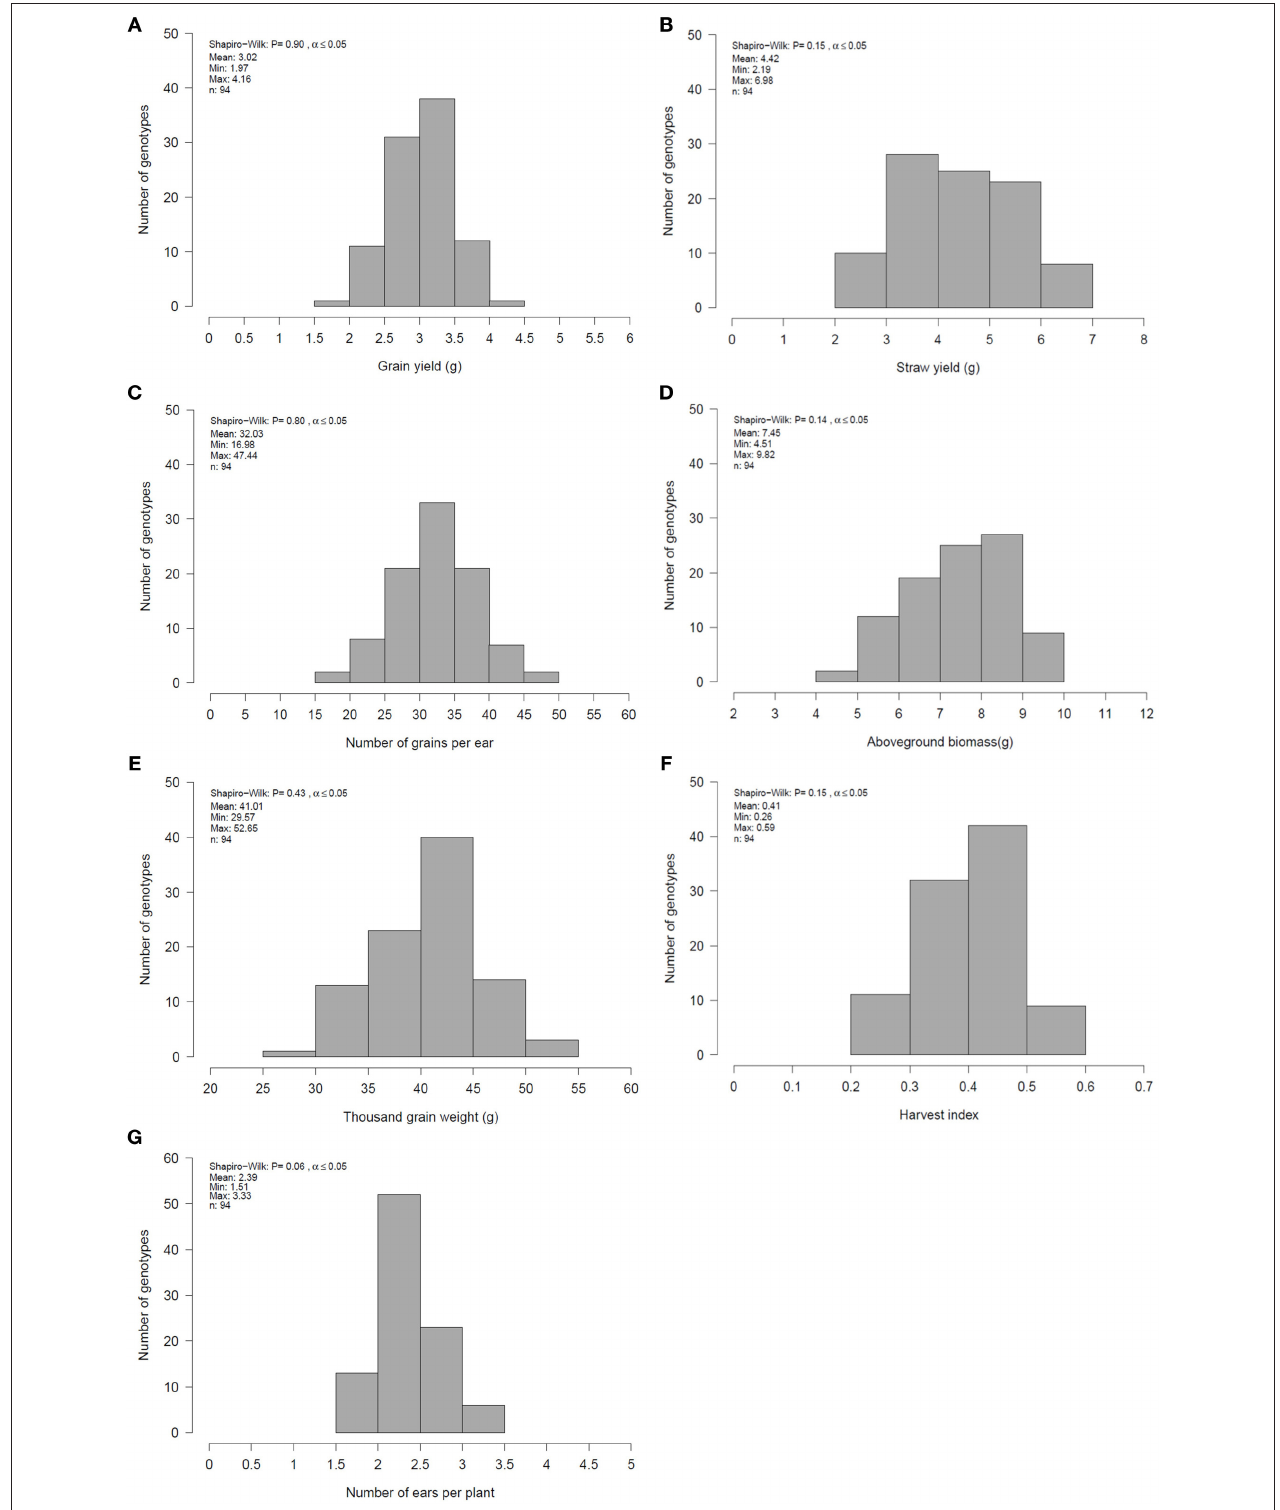
FIGURE 1 | Mean, minimum (Min), maximum (Max) and distribution of genotype means for (A) grain yield (GY), (B) straw yield (SY), (C) number of grain per ear (GN), (D) aboveground biomass (BM), (E) thousand grain weight (TGW), (F) harvest index (HI) and (G) number of ears per plant (EN) for 94 genotypes across all environments evaluated in 2